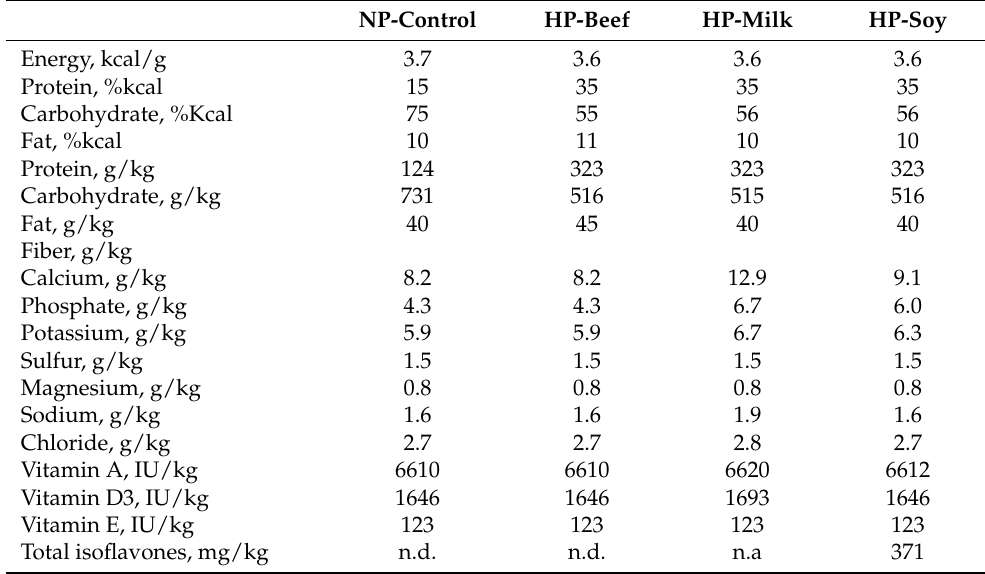
Table 2. Macro- and micronutrient composition of energy-restricted diets 1